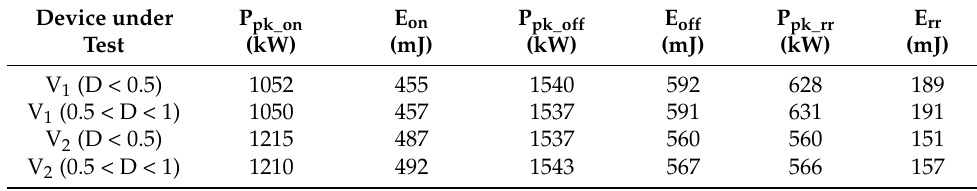
Table 7. The switching parameters’ comparison with different current paths in buck mode.